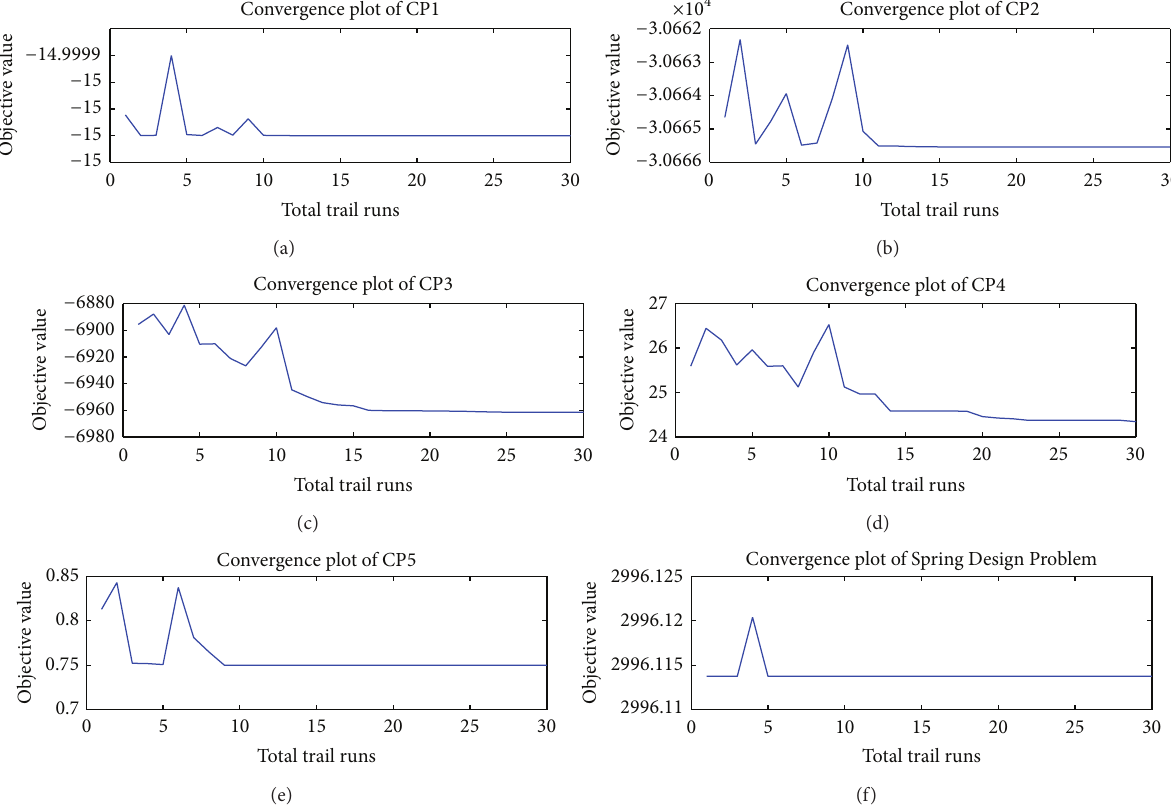
Figure 5: Performance of SbPPA on constrained global optimization problems (see